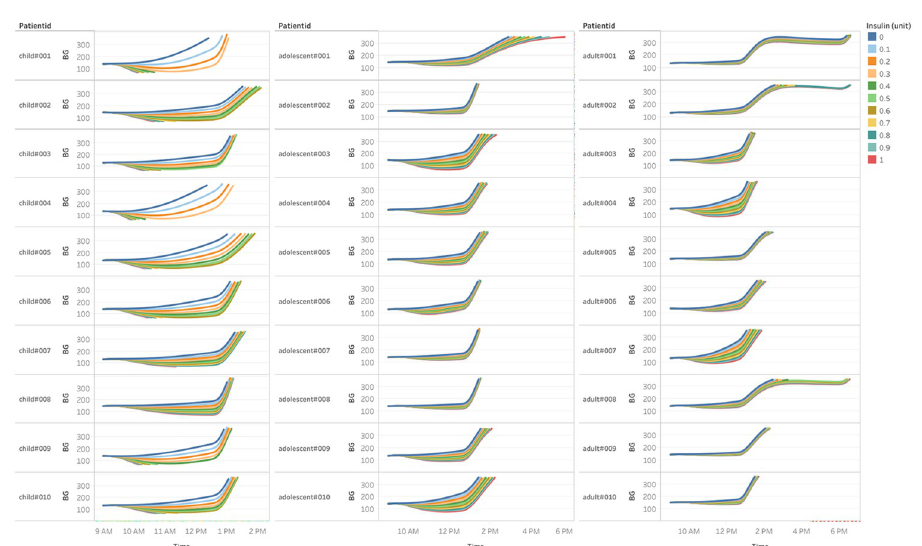
Fig 3. Insulin response time for each patient. The insulin dose depicted in the color legend on the right was injected at 9:00 AM and no meal is taken subsequently.